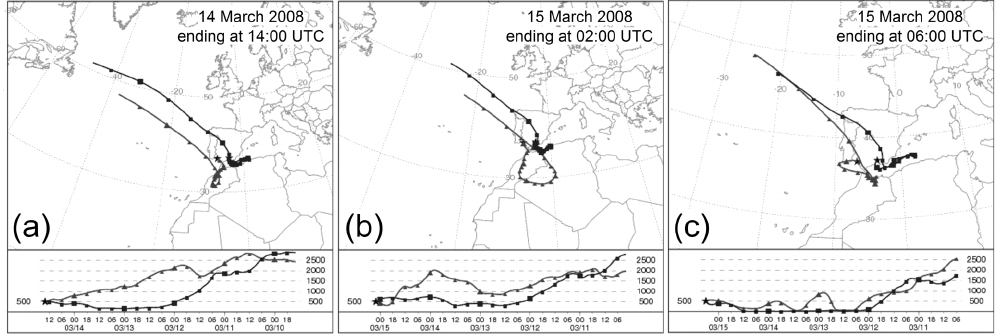
Fig. 10. HYSPLIT 5-day backtrajectories ending at 500m height a.g.l. over both ARN (triangle line) and GRA (square line) sites. Fig- ure panels correspond to three representative dates and times for that dust episode: (a) 14 March at 14:00UTC, (b) 15 March at 02:00UTC, and (c) 15 March at 06:00UTC.